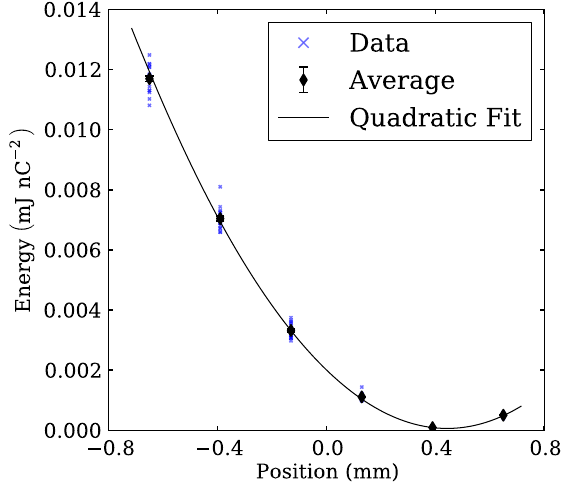
FIG. 13. Signal amplitudes from the different channels during a vertical calibration with the phase of the signal from the vertical position cavity channel also